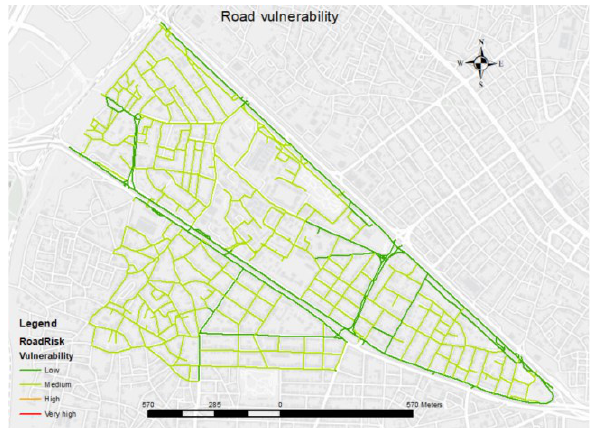
Figure 5 . Road vulnerability. Source: de Vries, 2022